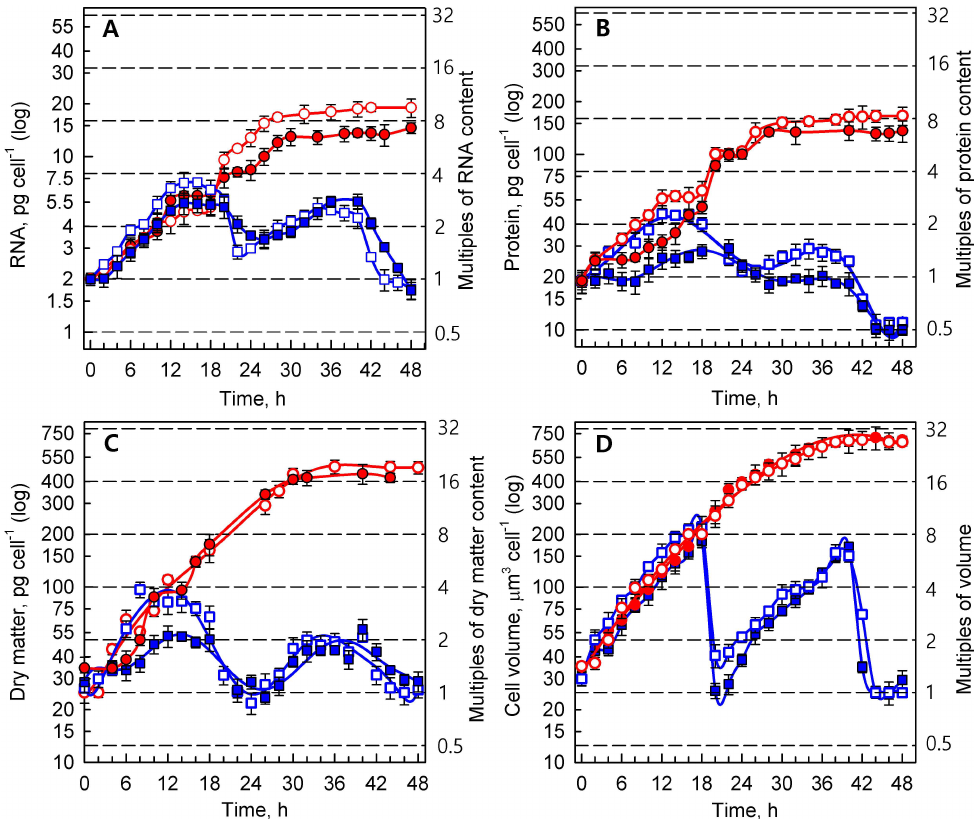
Figure 2. Time course of growth events in synchronized cultures of Parachlorella kessleri grown at 30 ◦ C and 40 ◦ C (blue and red symbols and lines, respectively), and at incident light intensities of 500 and 110 µ mol photons m − 2 s − 1 (empty and full symbols, respectively). ( A ) RNA (pg cell − 1 ), ( B ) protein (pg cell − 1 ), ( C ) dry matter (pg cell − 1 ), and ( D ) cell volume ( µ m 3 cell − 1 ). Horizontal dashed lines indicate the number of doublings of the initial values at the beginning of the cell cycle (0 h). Multiples of these values are given at right ordinate. Data are presented as means ± SE. The differences between 30 ◦ C and 40 ◦ C are statistically significant at p < 0.001 (two-way ANOVA) in both A and B.